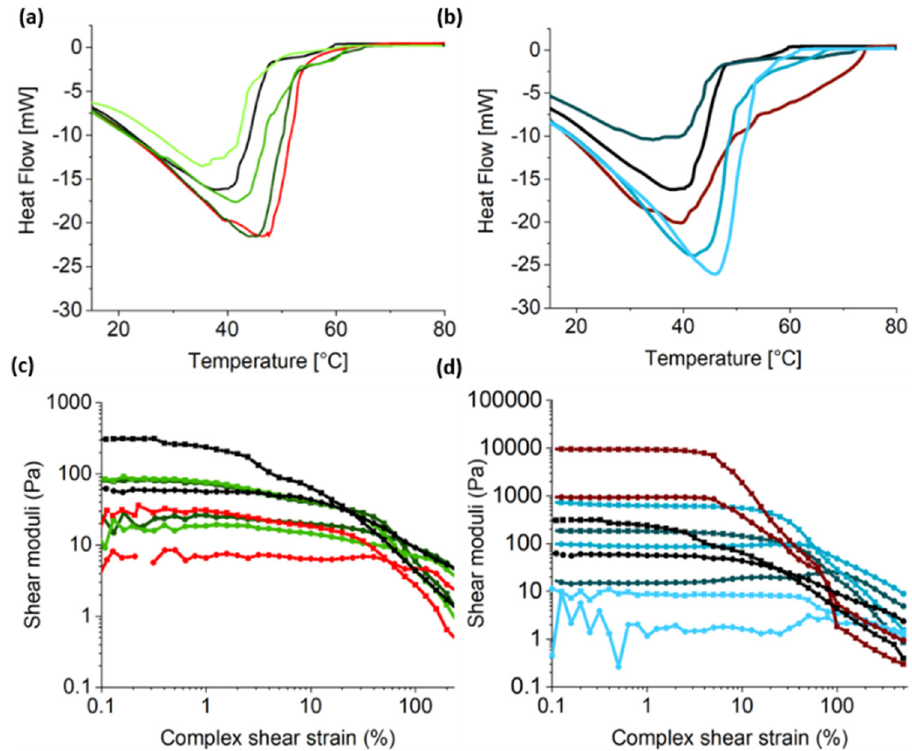
Figure 5. DSC thermograms of the multicomponent supramolecular hydrogels alongside single- component hydrogels at the ( a ) 1:1 and ( b ) 2:1 ratio. Rheology studies showing oscillatory amplitude sweeps at a constant frequency (1 Hz) ( c , d ). All gels exhibited a linear viscoelastic regime. In oscillatory experiments, ▪ refer to G’ and • refer to G”, the storage modulus and viscous modulus, respectively. For all datasets, multicomponent samples 1:1 Ag:GMP stoichiometry and varying FY concentrations; samples: A ( ― ), B ( ― ), and C ( ― ) and at 2:1 Ag-GMP stoichiometry and vary molar ratios; samples: D ( ― ), E ( ― ), and F ( ― ). Red lines refer to the control Ag-GMP gel samples.